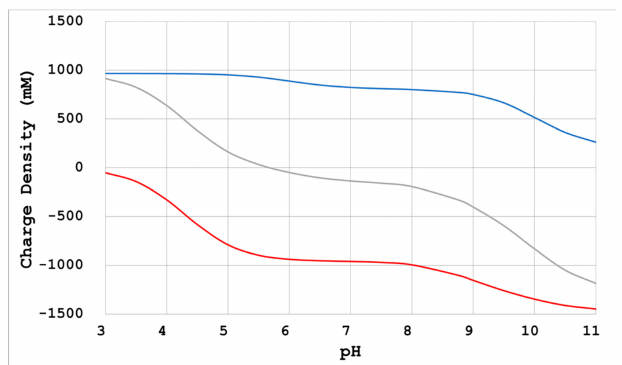
Figure 2. Charge density calculated from the amino acid composition (human serum albumin). Red line: positive charge density; gray line: negative charge density; blue line: total charge density. Based on the amino acid composition of the protein sample, not only the molecular weight, but also the electric charge number at a specific pH, can be calculated [11]. Additionally, the electric charge density can be calculated by dividing this electric charge number by the estimated lattice volume